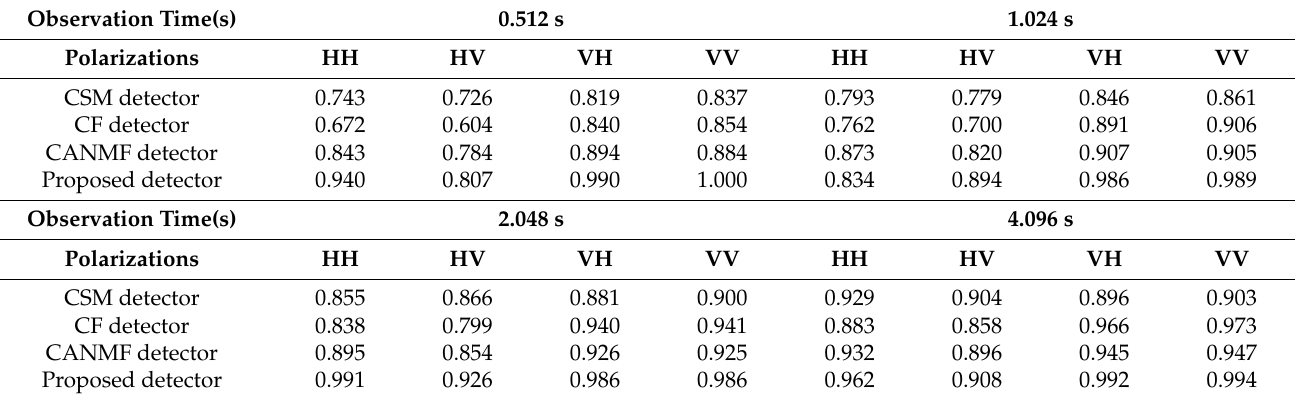
Table 3. Average detection probabilities of the detectors on the 20 datasets at four